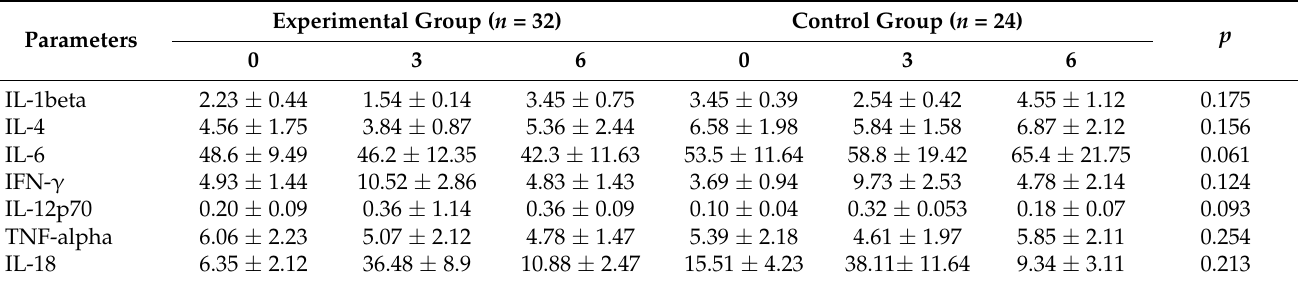
Table 3. Biochemical evaluation and clinical parameters of the experimental group (FIR) and control group